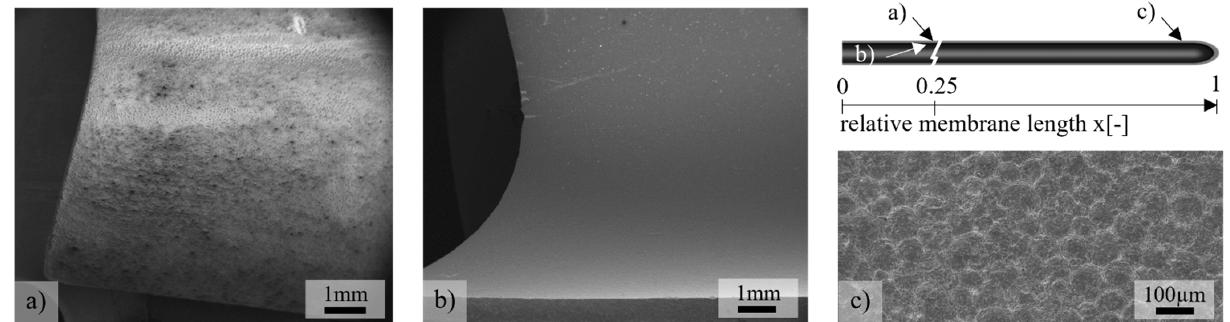
Figure 5. SE-images of a failed tubular membrane after 1800 h module operation, ( a ) blue discolored outer surface (fracture position), ( b ) corresponding inner surface, ( c ) outer surface exposed to 850